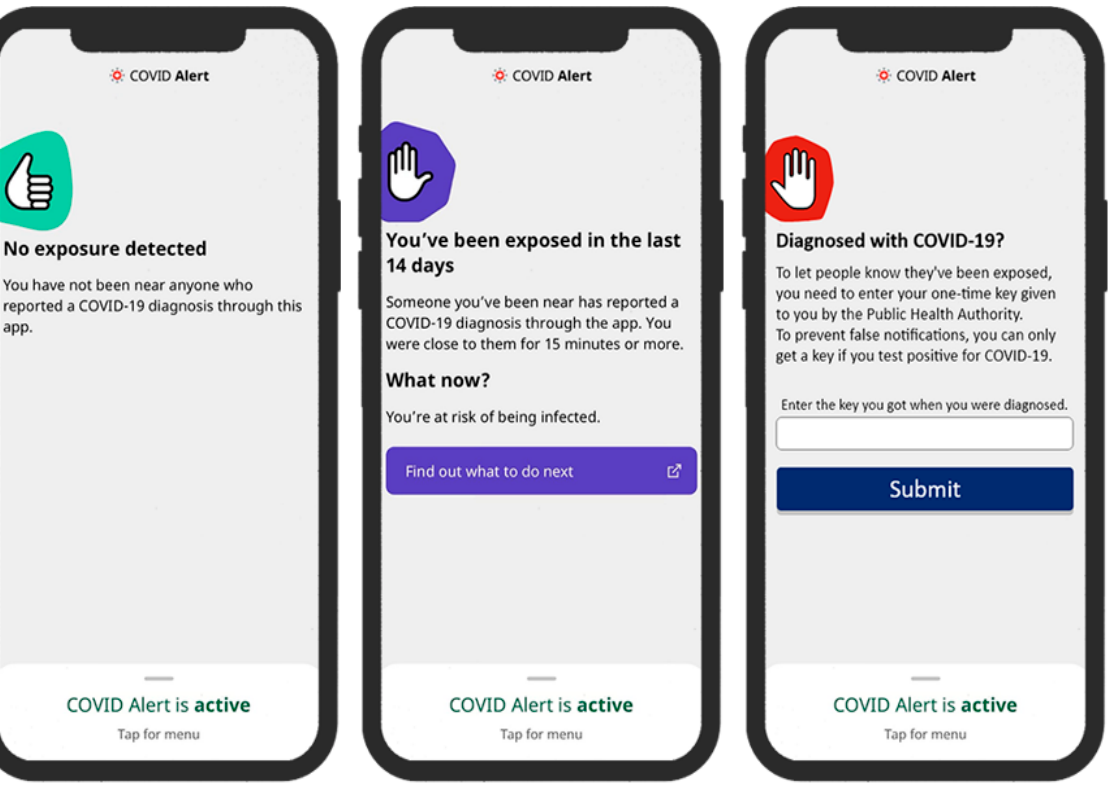
Figure 2. Control versions of key UIs of COVID Alert [18].